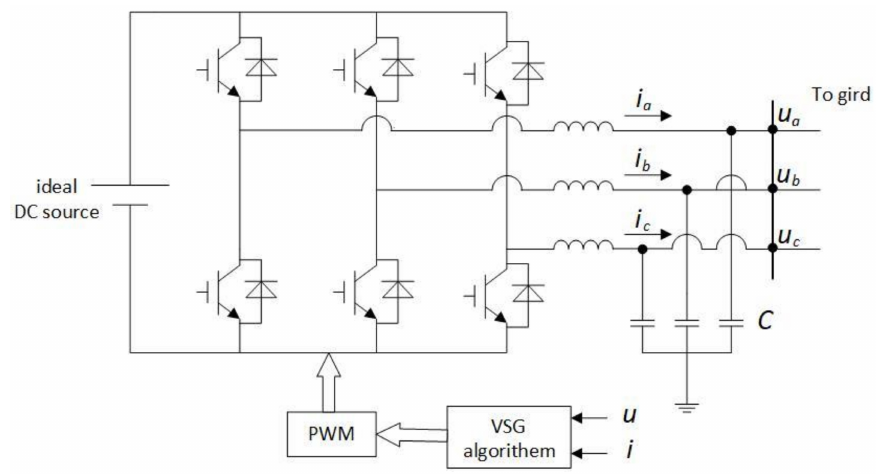
Figure 6. Schematic of VSG